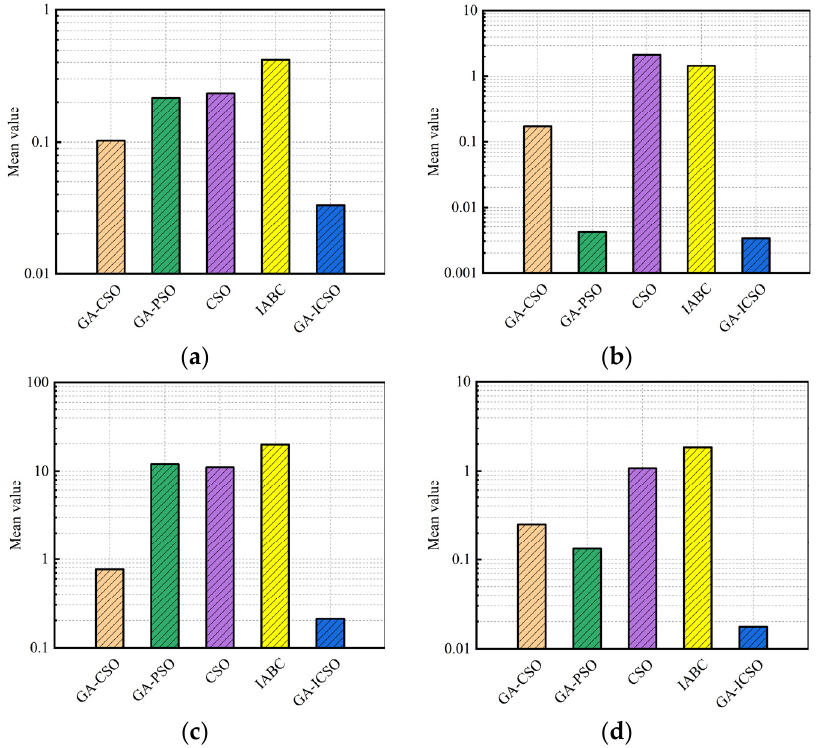
Figure 11. Average function evaluations for four test functions: ( a ) Griewank; ( b ) Zakharovfcn; ( c ) Ackley; ( d ) Schwefel 2.21.